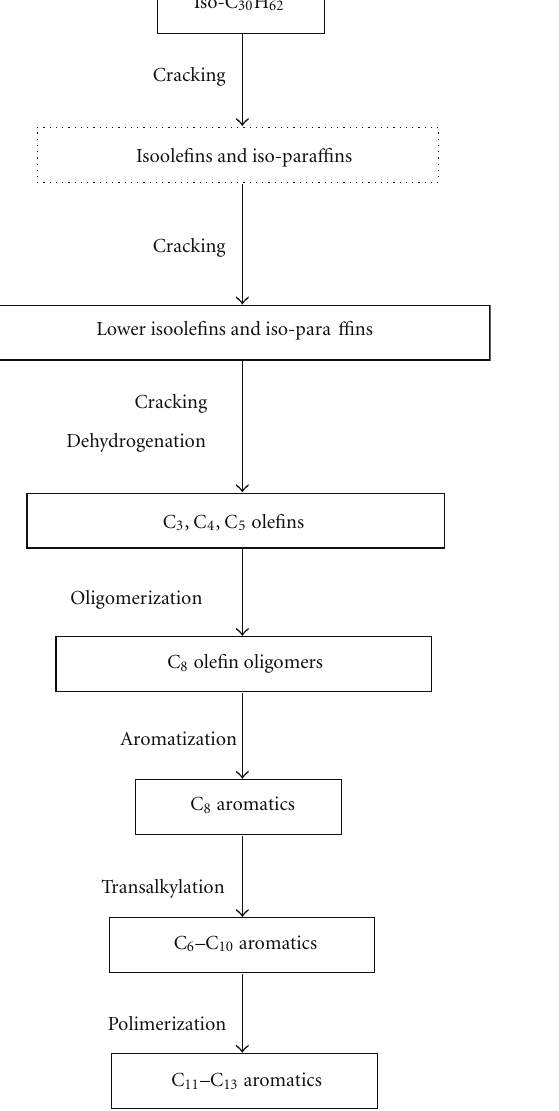
products1 Carbon number of cracked